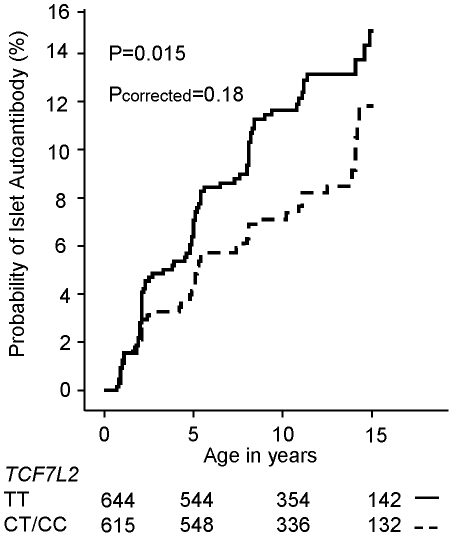
Cumulative risk for the development of autoantibodies by the TCF7L2 genotypes.Children are grouped with respect to TCF7L2 SNP rs7901695 genotype into those carrying TT genotype (solid line) and the CT or CC genotype (dashed line). Follow-up (x-axis) is from birth. Numbers below the x-axis indicate the number of autoantibody negative children remaining on follow-up with respect to age.